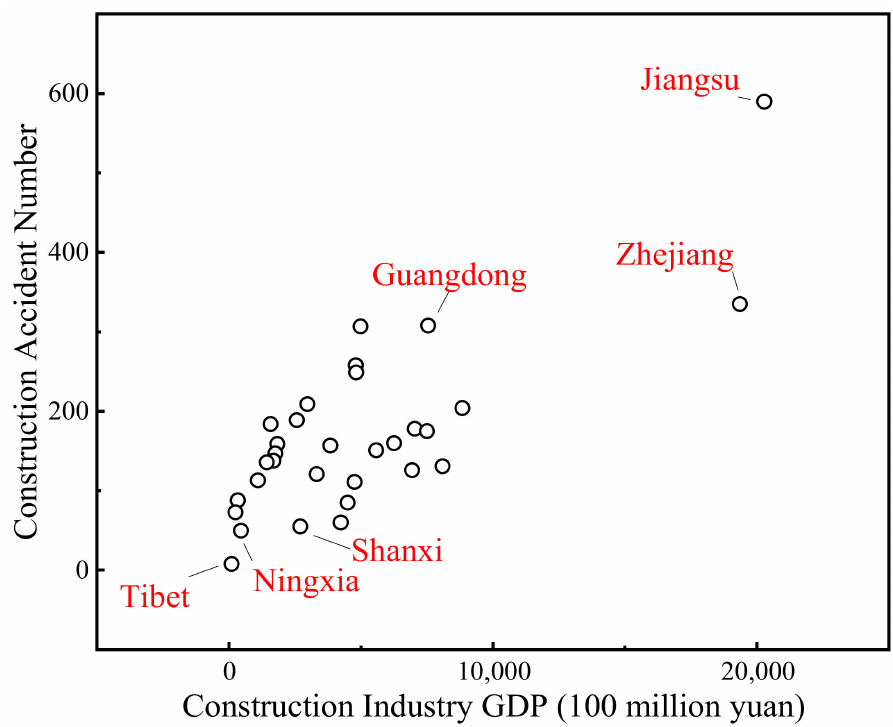
Figure 4. Scatter plot of construction accidents and construction industry